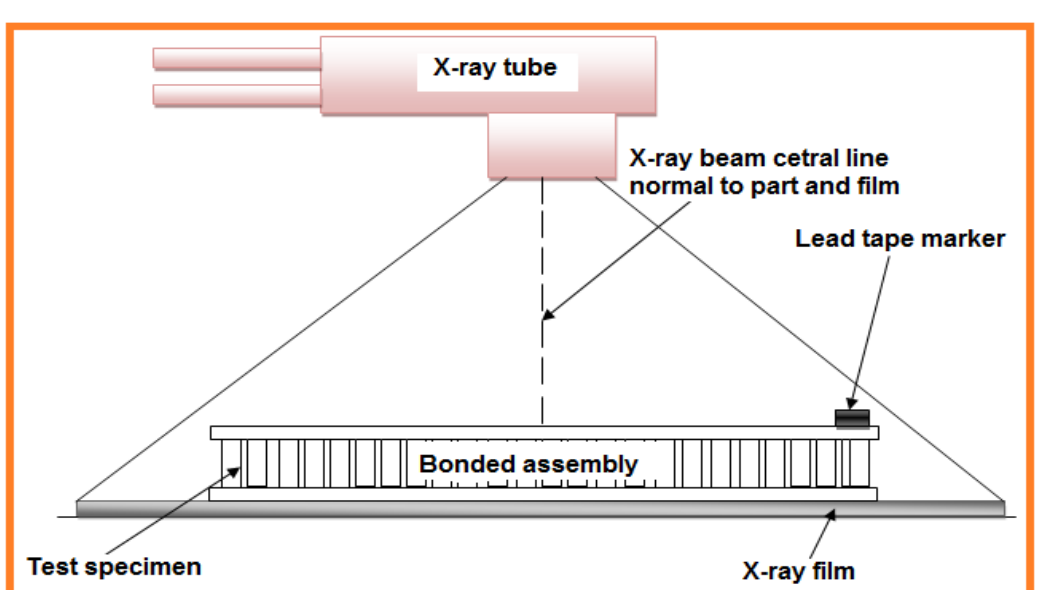
Figure 7. Radiography inspection method assembly for micro crack detection.